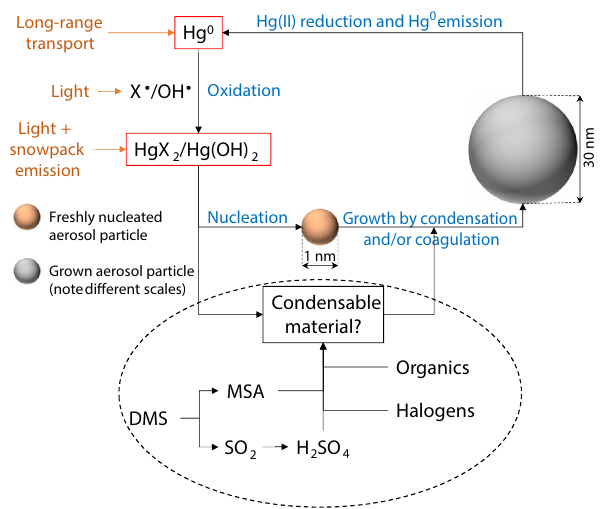
Figure 9. A suggested nucleation and growth mechanism driven by atmospheric mercury present from long-range transport. This chem- istry is likely only to occur under conditions of low background aerosol surface area, otherwise these reaction products are more likely to adhere to pre-existing aerosol surfaces. Species highlighted in red constitute what is measured as TGM. Evidence suggests that no single species, DMS, organics, or halogens, can explain growth rates; however, they may combine into a single reservoir of con- densable material that may contribute to the growth